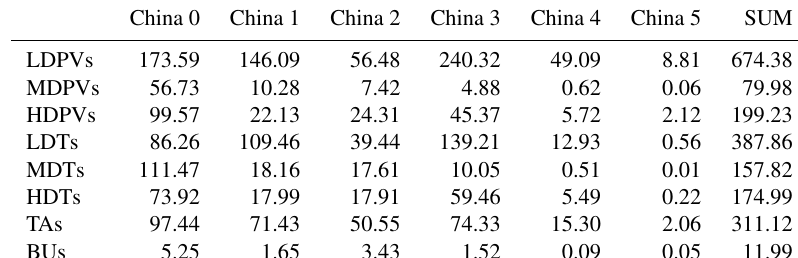
Table 4. VOC tailpipe emissions by vehicle type and by emission control technology in China in 2015 (Gg).